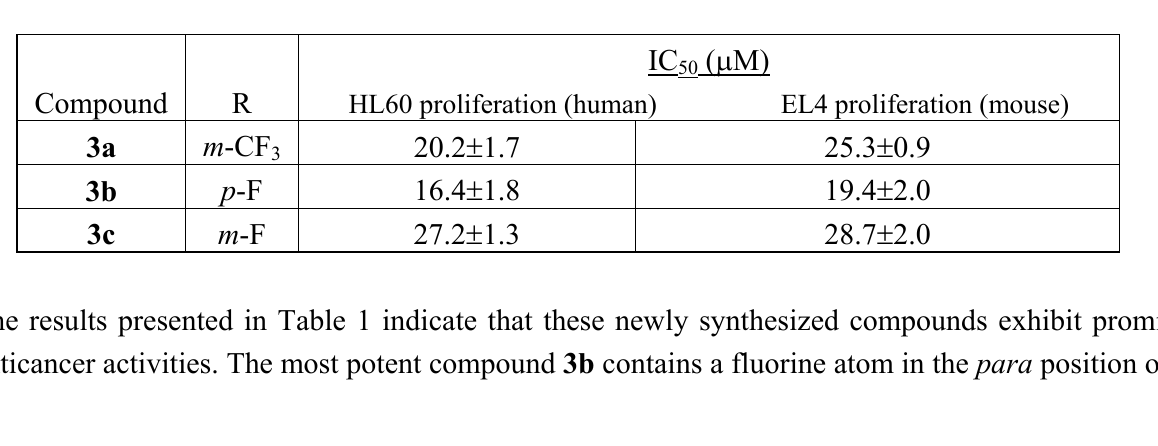
Table 1 . Evaluation of pyrazole